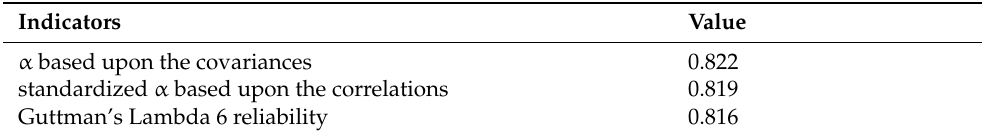
Table 7. Traditional scale reliability indices.